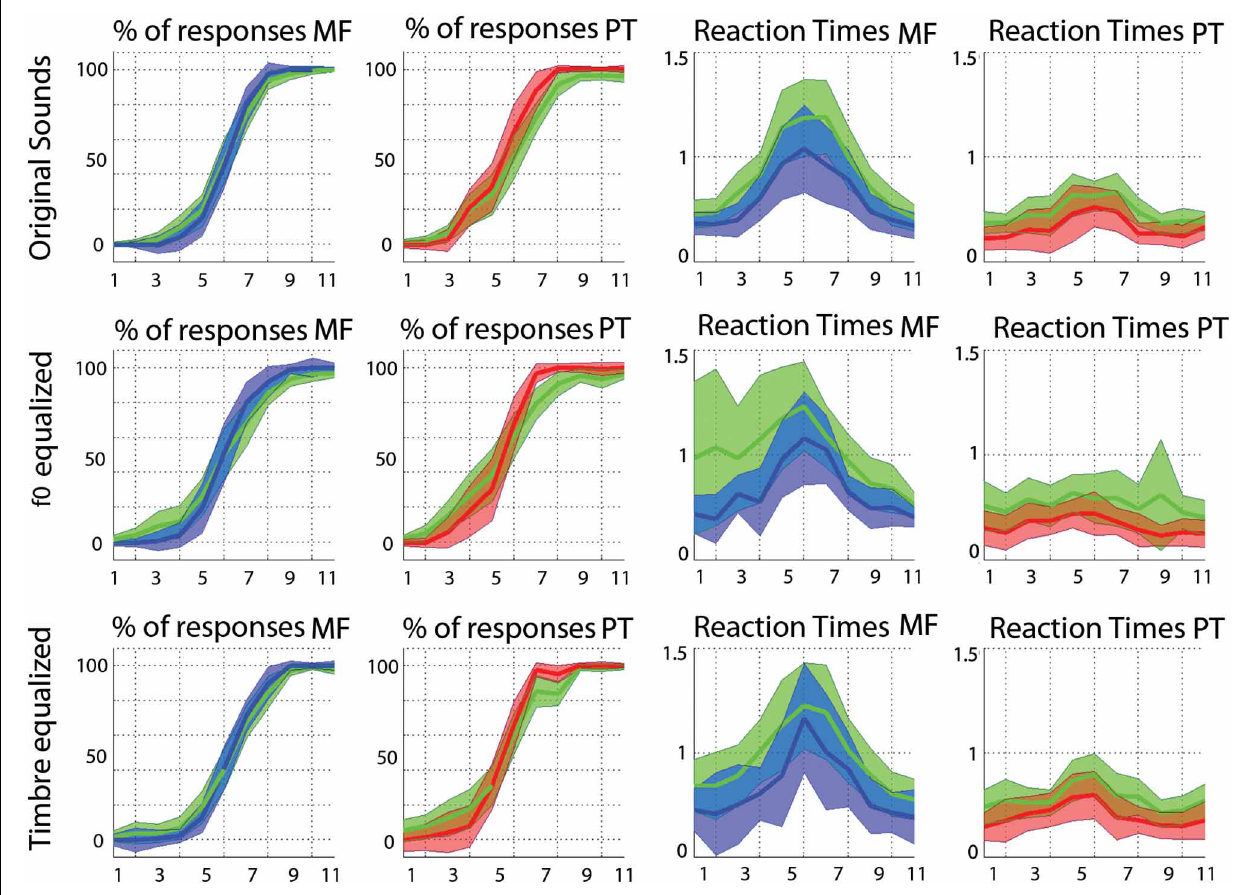
FIGURE A1 | Comparisons between the “standard” mean computed on raw data with the 95% confidence interval (in green) and the robust alternative: trimmed means on cleaned data with bootstrapped 95% confidence intervals (in blue for the gender task, and in red for phoneme task).